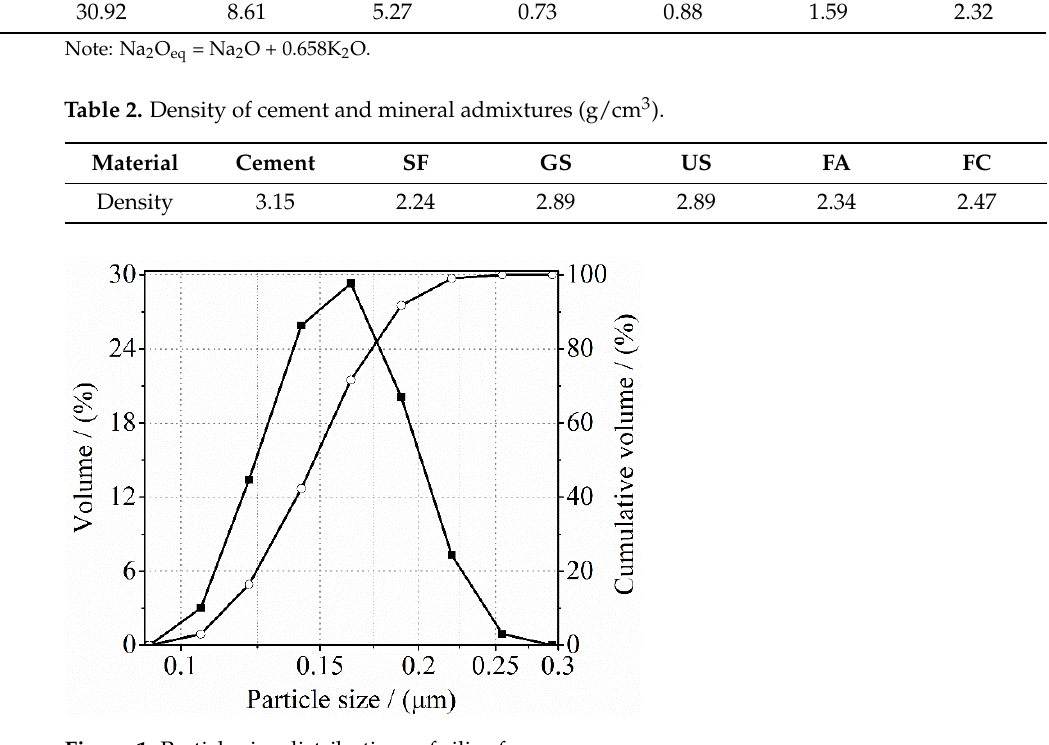
Figure 1. Particle size distributions of silica